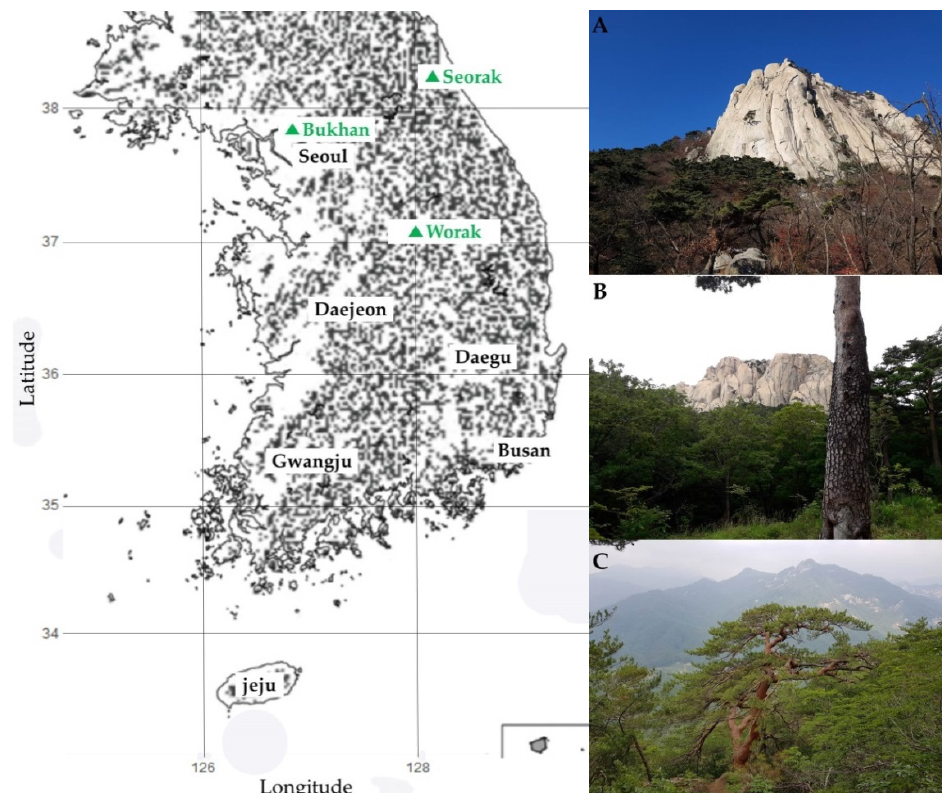
Figure 1. Location of study sites (triangle) and overview of sampling sites (( A ): Mt. Bukhan, ( B ): Mt. Seorak, ( C ): Mt. Worak). Table 1. Site characteristics and sample replication.